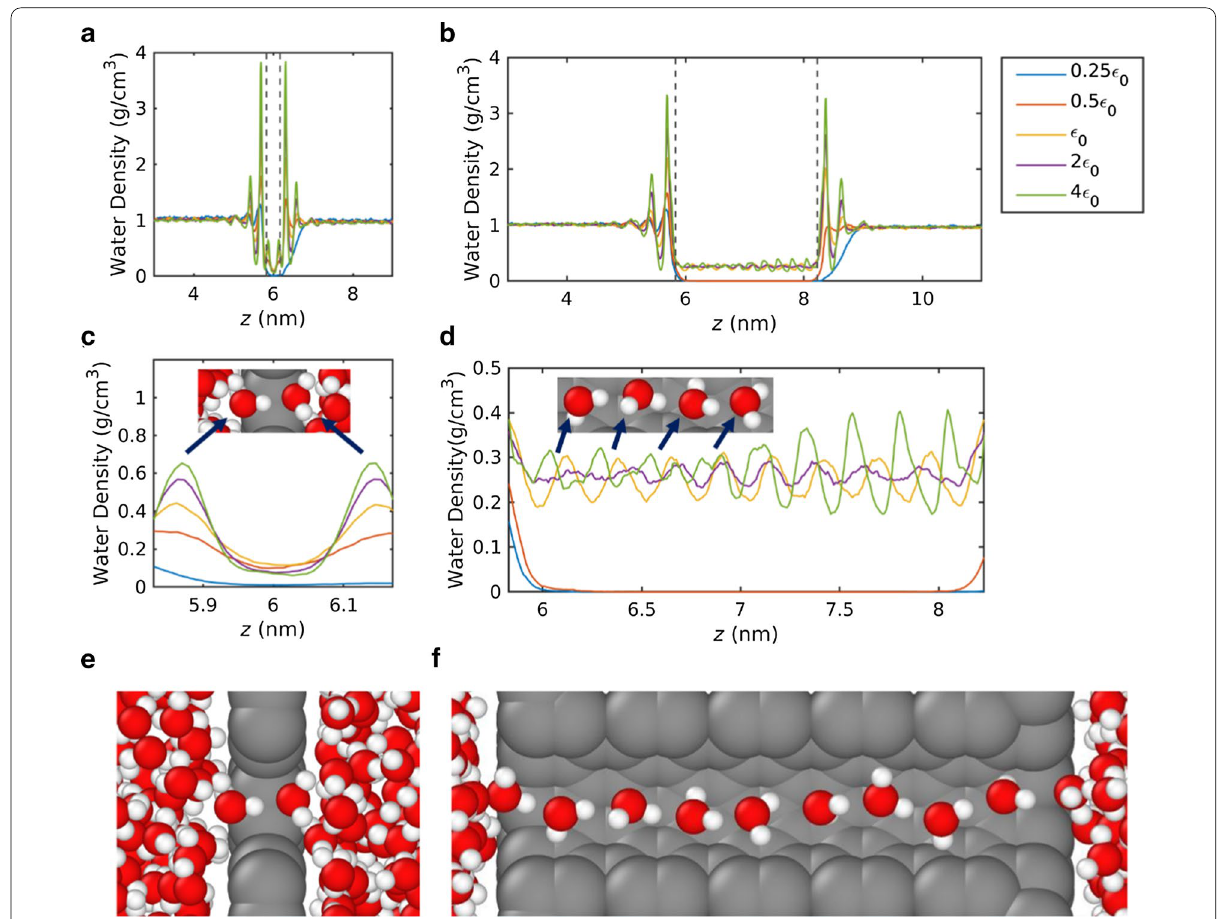
Fig. 3 a – d Water density profile and e – f visualized single-file water formation during MD. Water density along the axial direction of the nanopore for a 2D membranes and b 3D membranes. Density was measured in cylindrical bins with a water accessible pore radius. Detailed density profile inside the pore region for the c 2D membrane and d 3D membrane. Single-file configuration inside the e 2D nanopore and f 3D